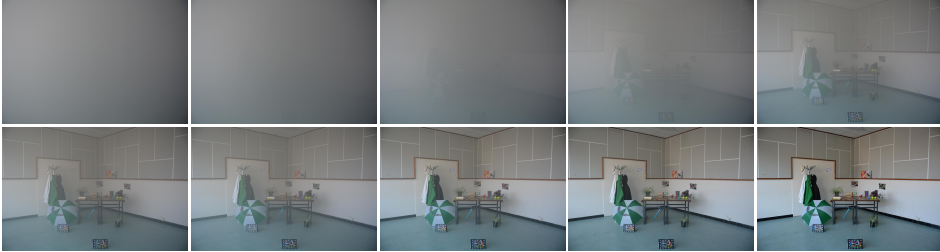
Figure 3. Images from Scene1 of CHIC. From left to right, the fog density levels of the images in the first row are 1 (the highest) to 5 and those in the second row are 6 to 10 (the clearest image).